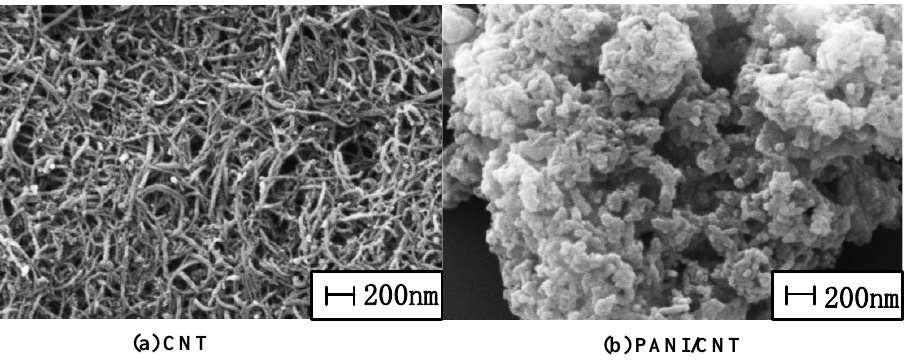
Figure 4. SEM image of two samples: ( a ) Unacidified CNT, in which other impurities exists with poor dispersion. ( b ) Polyaniline adhered to the surface of chemically acidified carbon nanotubes.